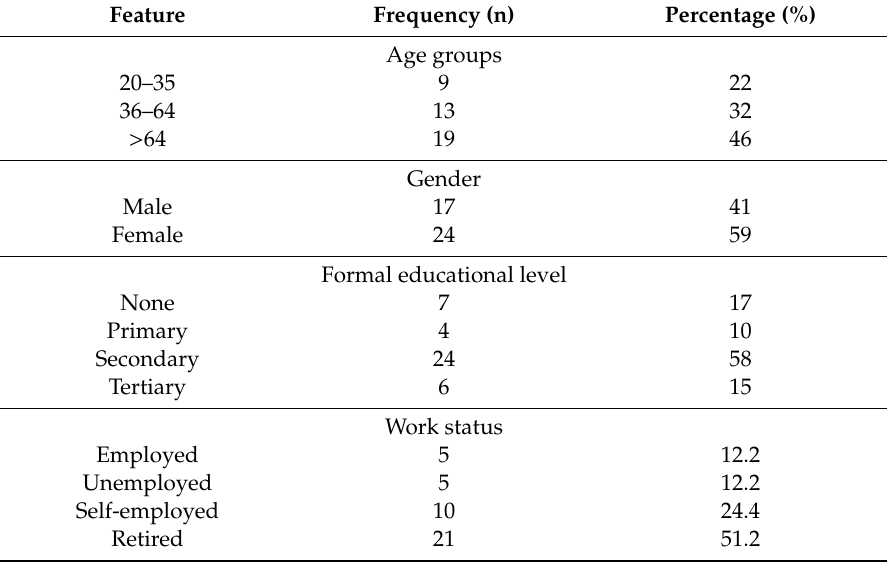
Table 1. Demographic characteristics of the participants in three (3) villages of Bushbuckridge Local Municipality, Mpumalanga province, South